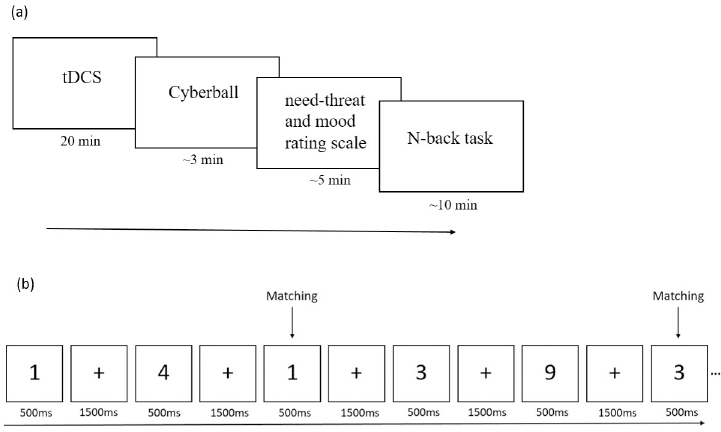
Fig 1. The experiment procedure. (a)Experiment procedure of the current study. Note that the Cyberball game was played at the last 5 minutes of the tDCS. (b)Example of the 2-back task.